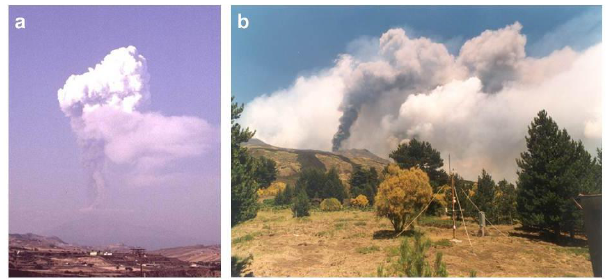
609 Figure 1. Examples of a) SSL plume produced during 22 July 1998 Etna eruption (courtesy of 610 Fig. 1. Examples of (a) SSL plume produced during the M. Pompilio); b) WLL plume formed on 24 July 2001 (photo taken by S.Scollo). 611 22 July 1998 Etna eruption (courtesy of M. Pompilio); (b) WLL 612 plume formed on 24 July 2001 (photo taken by S.